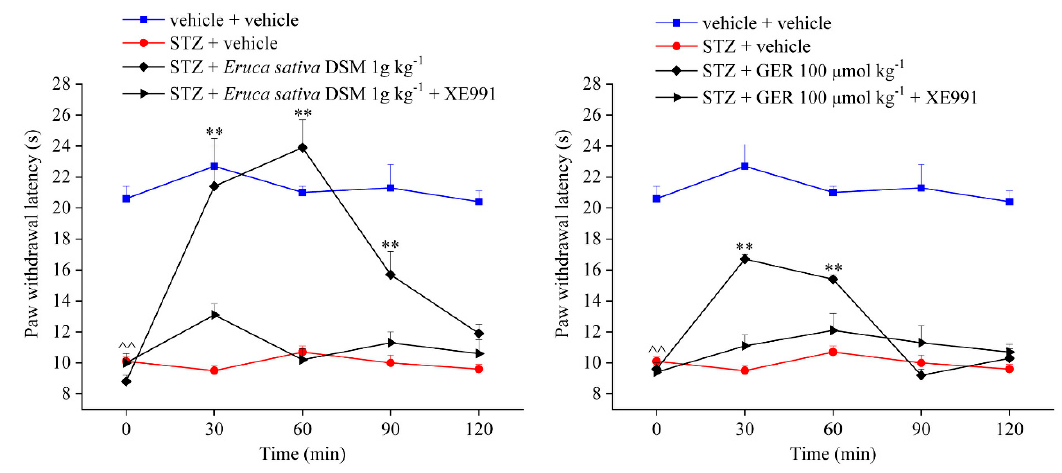
Figure 5. Involvement of Kv7 potassium channels in the pain-relieving effect of Eruca sativa defatted seed meal (DSM) and glucoerucin (GER). The response to a mechanical stimulus was evaluated by measuring the latency to pain-related behaviors (paw withdrawal). ( a ) Myrosinase (Myr)-bioactivated Eruca sativa DSM (1 g kg − 1 ) and ( b ) GER (100 µmol kg − 1 ) were orally administered in concomitance with XE991 (1 mg kg − 1 ip); tests were performed 30, 60, 90, and 120 min after injection. ^^ p < 0.01 versus vehicle + vehicle-treated mice; * p < 0.05 and ** p < 0.01 versus streptozotocin (STZ) + vehicle- treated mice.